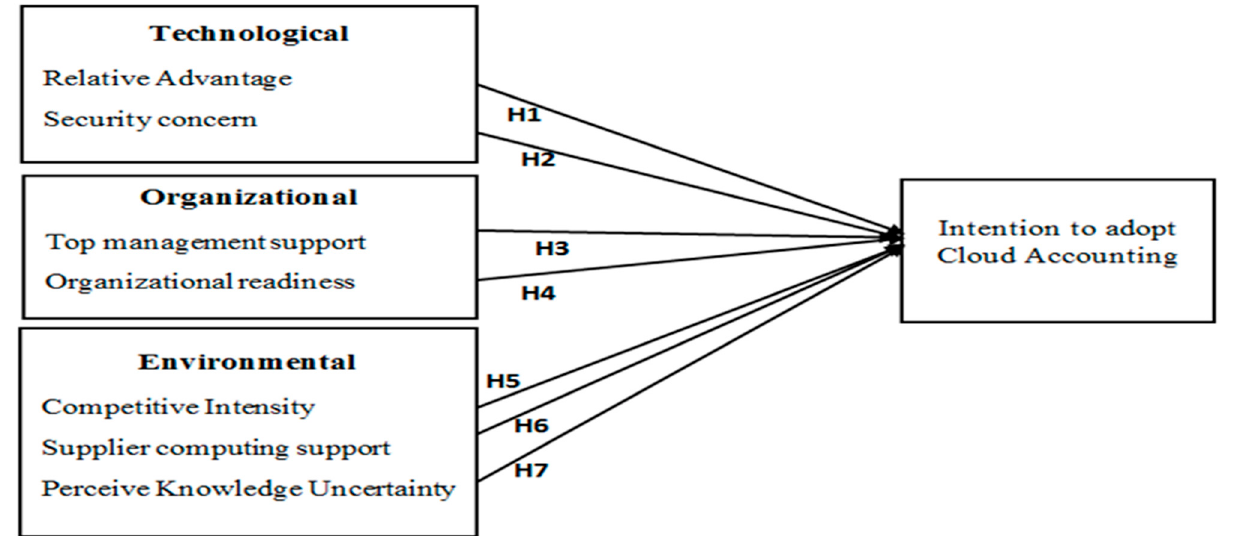
Figure 1. Proposed study model.